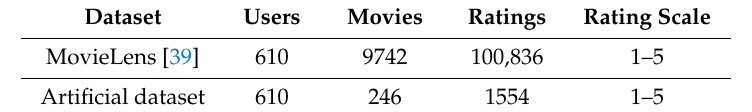
Table 11. Summary of datasets for user similarity detection engine (USDE) comparison.